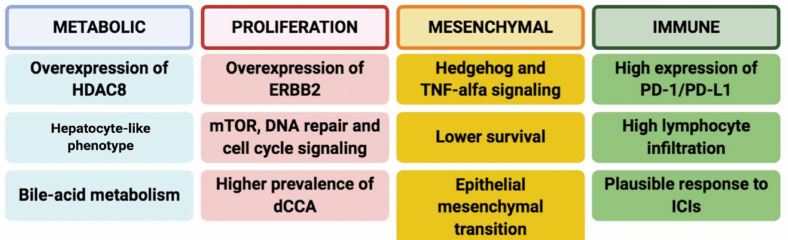
Figure 3. SchemereportingmolecularandclinicalfeaturesoffoureCCAsubclasses(Metabolic,Proliferation, Mesenchymal, and Immune) according to recent evidence [39]. In particular, the Metabolic class (18.7% of cases) mainly included gene expression data suggestive of deregulated bile acid-metabolism and impaired metabolism of xenobiotics and fatty acids; moreover, classic hepatocyte markers (including albumin, transferrinandCYP3A4) wereoverexpressedinthisclass, togetherwiththe tubulindeacetylase HDAC. The eCCA Proliferation class, accounting for 22.5% of the cohort, presented ERBB2 protein overexpression, with activation of the cell cycle, mTOR, and ERBB2, resulting in the key features of this class. Of note, the Proliferation class included a higher prevalence of dCCA (82%). The eCCA Mesenchymal class, accounting for 47.3%, was defined by genomic signals of epithelial-to-mesenchymal transition and by TGF-beta signaling activation, with worse clinical outcomes. Lastly, the Immune class (11.5%) presented upregulation of adaptive immune response genes—cytotoxic CD8 + T cells and B cells, providing the rationale for the use of immune checkpoint inhibition in this